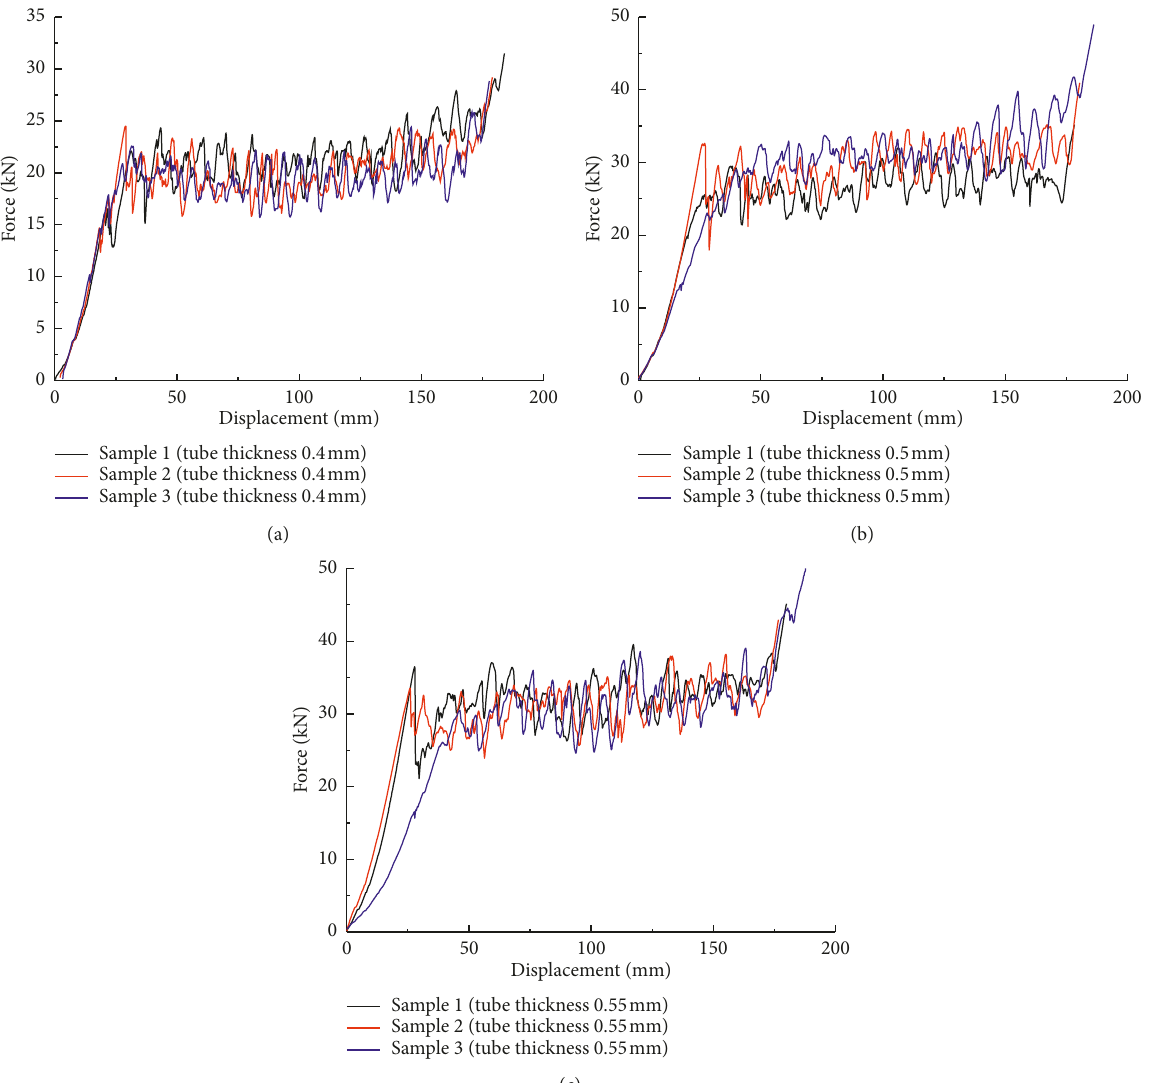
Figure 10: Quasistatic tensile load-displacement curves of the symmetric tube-crushing dissipators with different tube thicknesses: (a) 0.4 mm, (b) 0.5mm, and (c)